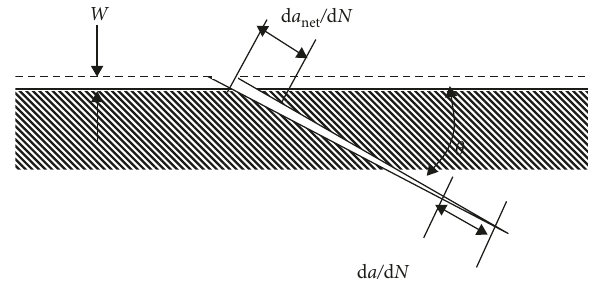
Figure 3: Diagram of the competitive relationship between wear and fatigue.